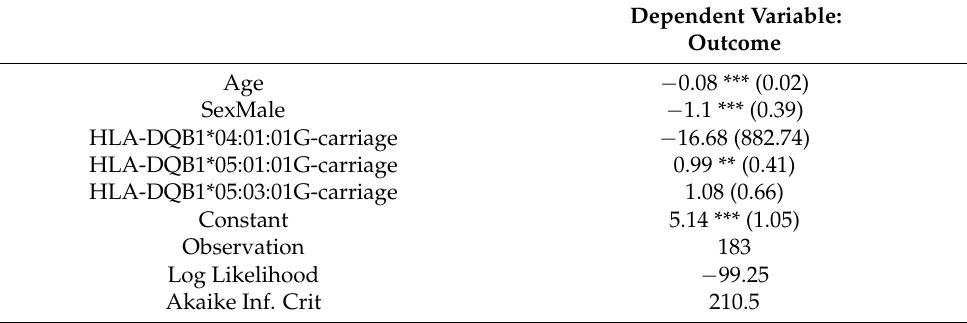
Table 14. Coefficients for ”Best” model by AIC for locus DQB1.